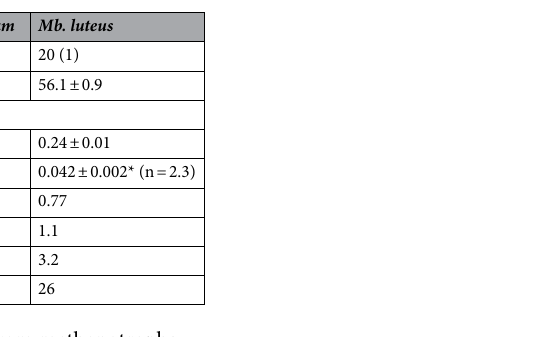
Table 2. The kinetic properties of GntKs from